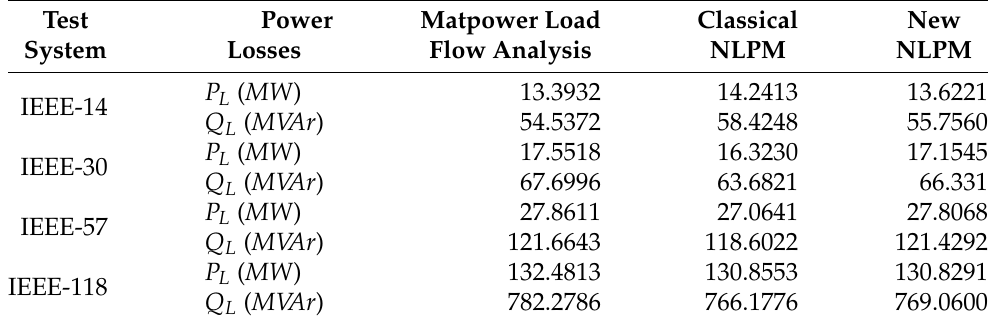
Table 6. Power loss for IEEE systems considering multiple bad data